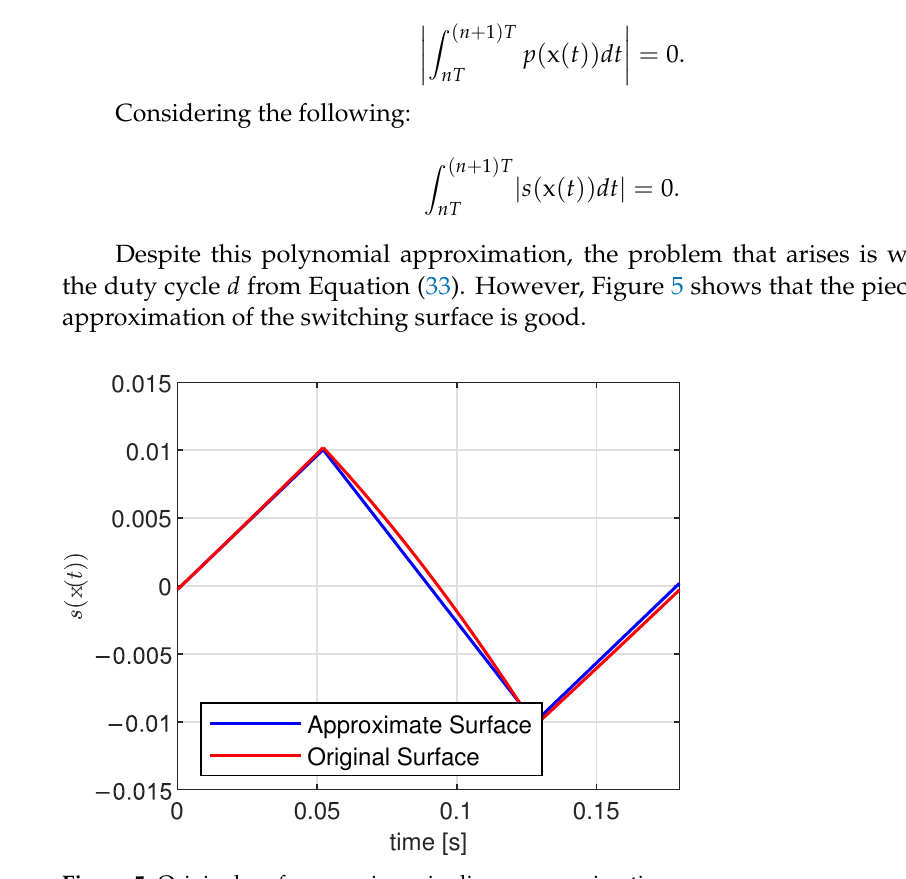
Figure 5. Original surface vs. piecewise linear